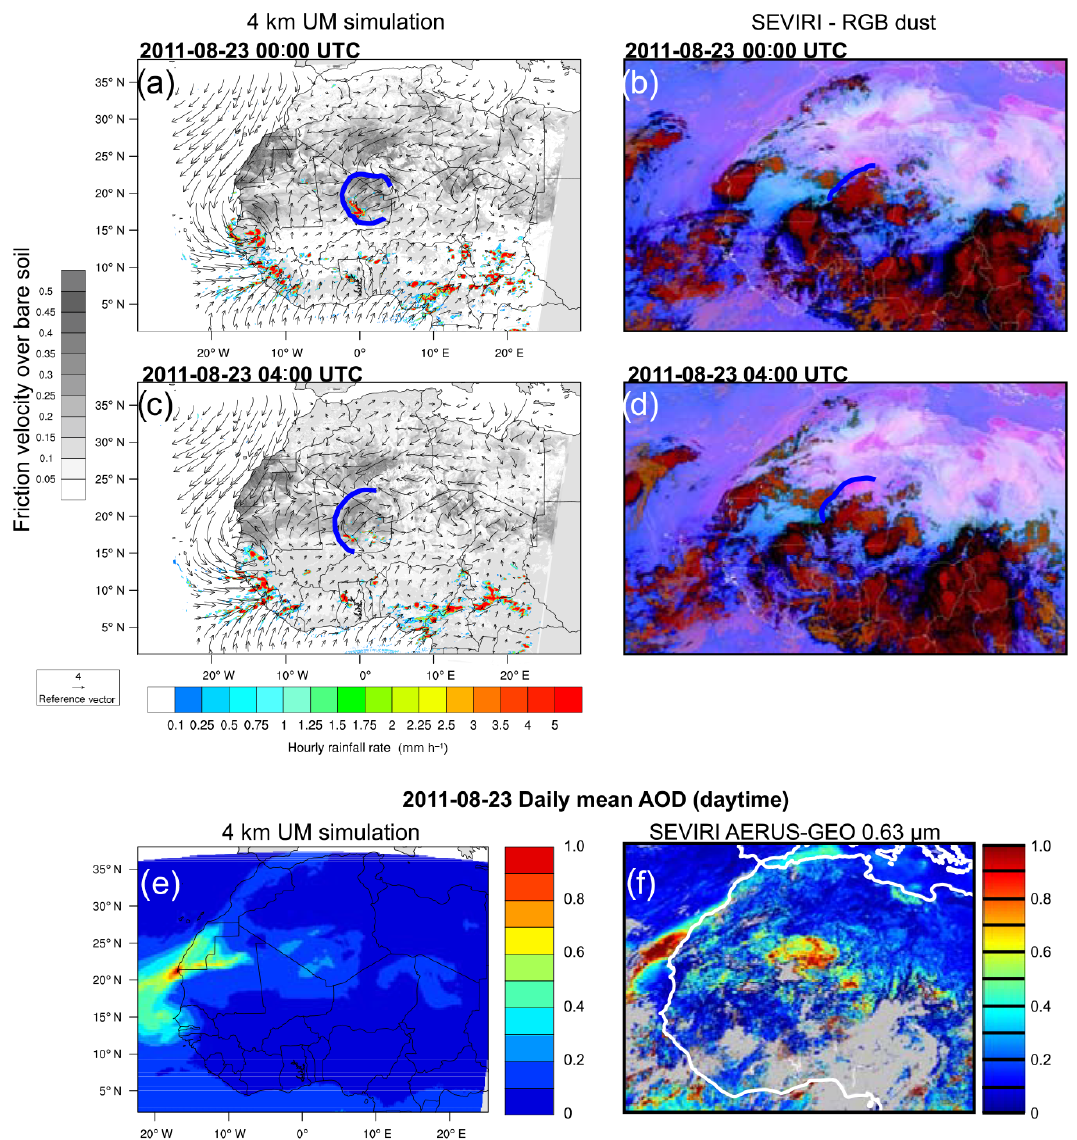
Figure 12. Case study of a large cold-pool event that occurred on the morning of 23 August 2011 that is present both in the observations and in the 4km explicit simulation. Panels (a, c) show simulated rainfall (colours), 10m wind (vectors) and friction velocity over bare soil (grey shading, a key feature in the emission of dust within the model). Panels (b, d) show SEVIRI false colour RGB dust imagery for the same times as panels (a, c) . The leading edge of the cold pool has been highlighted in blue where visible on both plots of the simulation and SEVIRI images. Panels (e, f) show simulated and observed AOD values (daytime means) for the day of the haboob. Observed AOD is from the SEVIRI AERUS-GEO AOD